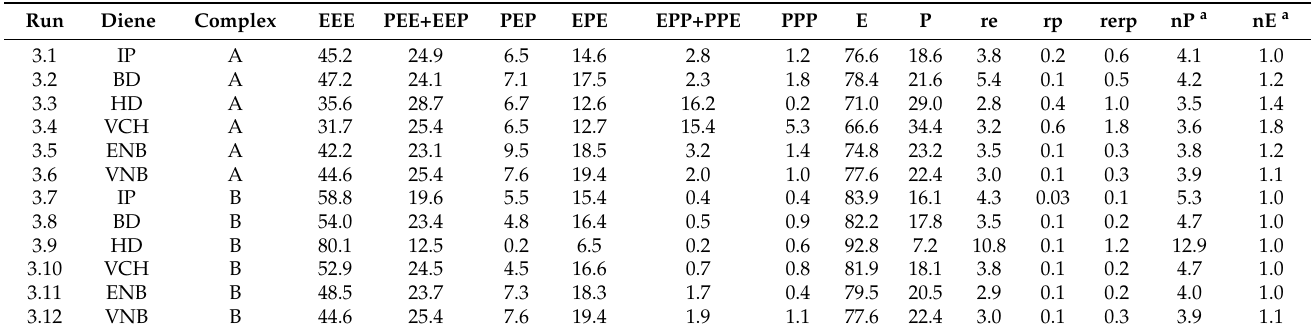
Table 4. Sequence distribution of terpolymers determined by 13 C